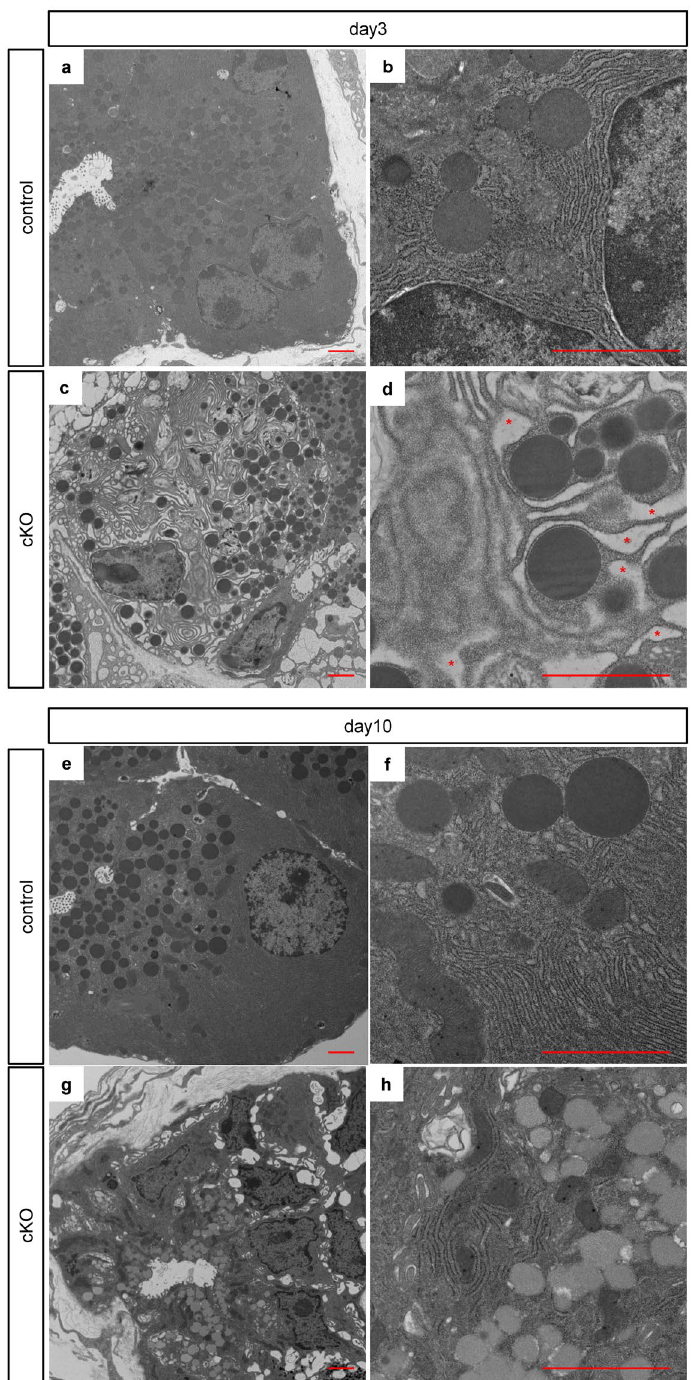
Figure 3. Activated endoplasmic reticulum stress in acinar cells of Ptf1a cKO mice. Representative findings of electron microscopy in control mice on day 3 ( a ) in Ptf1a cKO mice on day 3 ( c ) in control mice on day 10 ( e ) and in Ptf1a cKO mice on day 10 ( g ). ( b , d , f , h ) are magnified images of ( a , c , e , g ). Note the dilated ER lumen (indicated by red asterisks) in Ptf1a cKO mice on day 3 ( d ). Scale bars = 2 μ